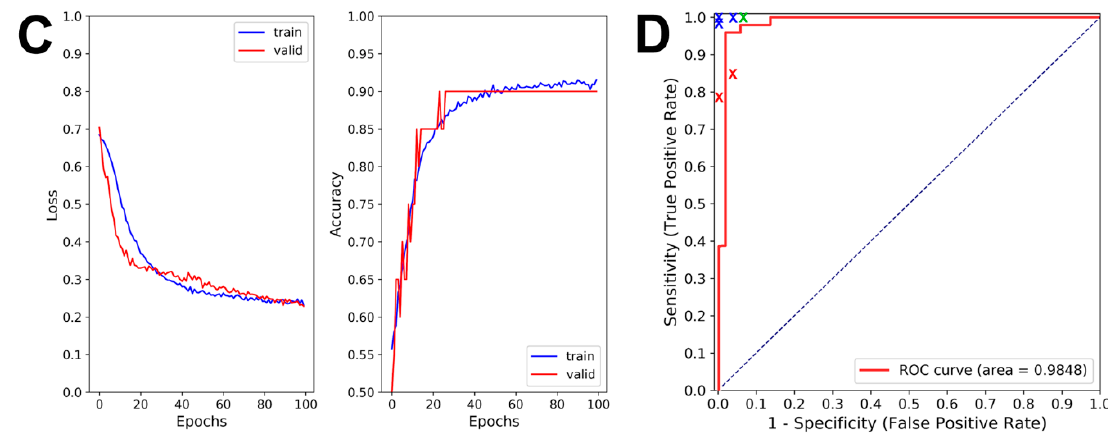
Figure 2. The learning curves and receiver operator characteristic (ROC) curves of our algorithms. ( A ) The learning curves of our final patch-level model. ( B ) The ROC curves of our patch-level models. The area under ROC curve (AUC) increased from 0.9675 ± 0.020 to 0.9900 ± 0.004 after expanding the training data with germinal centers and benign epithelial cells ( p = 0.000018). ( C ) The learning curves of our slide-level model. ( D ) The ROC curve of our slide-level model. The results of pathology residents (red crosses), chief resident (green cross), and attending pathologists (blue crosses) were included for comparison.